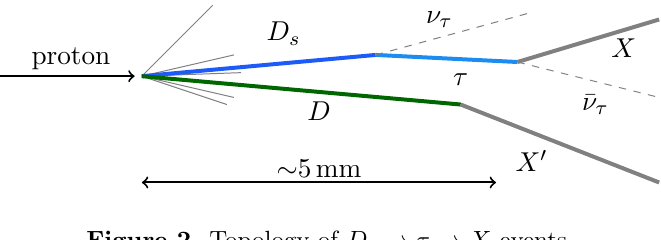
Figure 2 . Topology of D s ! (cid:28) ! X